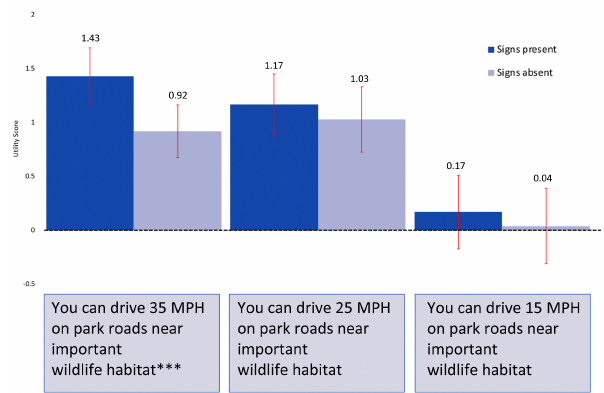
Fig. 4. Comparison of marginal utility coefficients for speed limit management strategies to reduce roadside background sounds levels. Significant differences between signs-present and signs-absent conditions are indicated by asterisks, where *** P < 0.001. 35 MPH = 56 km/h, 25 MPH = 40 km/h, and 15 MPH = 24